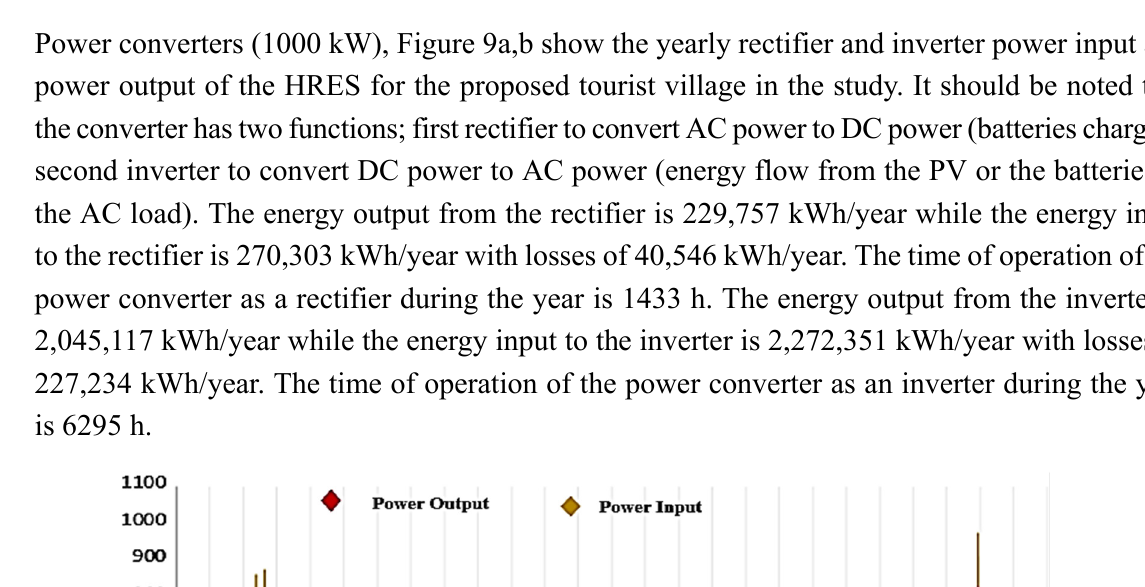
Figure 8. The yearly diesel generator power output of the HRES for the proposed tourist village in the